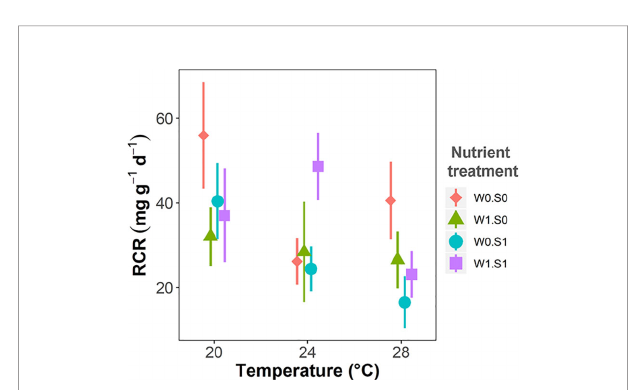
FIGURE 6 | Temperature effects on plant palatability to the pond snail L. stagnalis expressed as relative consumption rate (RCR), indicated per nutrient treatment. Nutrient treatments are as indicated in Figure 2 . Vertical bars are standard errors (n =